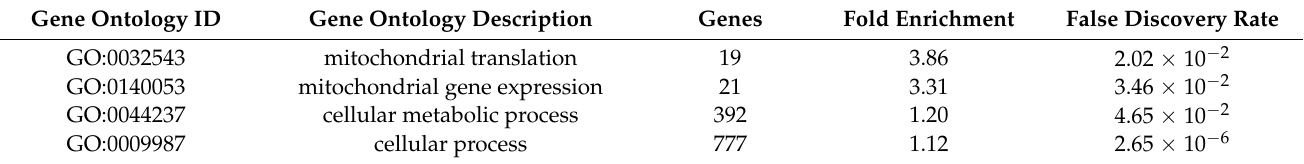
Table 1. Gene ontologies enriched for the selected features.